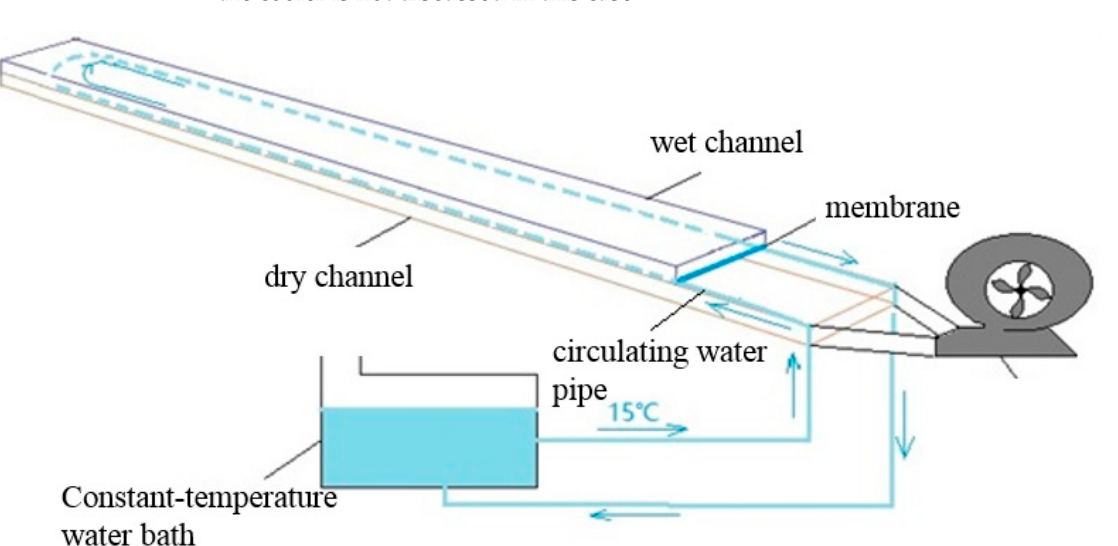
Figure 4. Prototype of membrane-based dew-point evaporative cooling system.